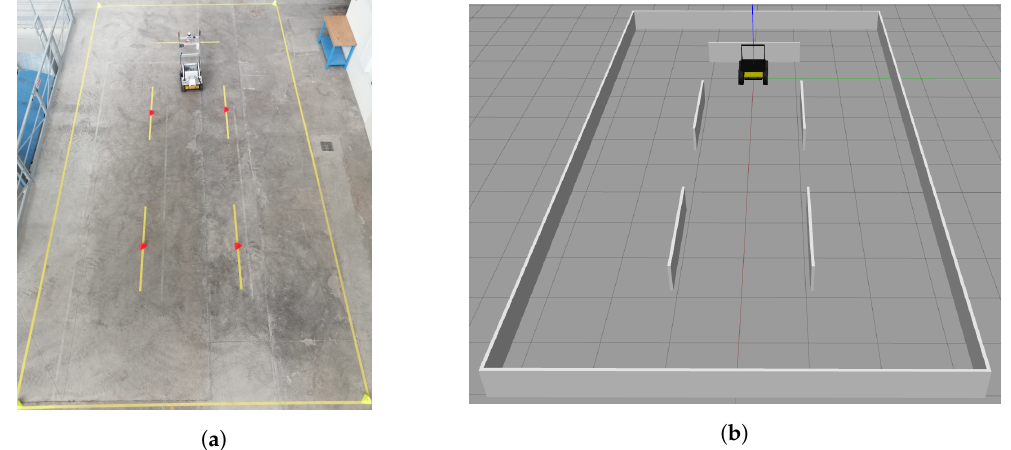
Figure 12. Robot working environment: ( a ) the real environment; ( b ) the simulated environment using